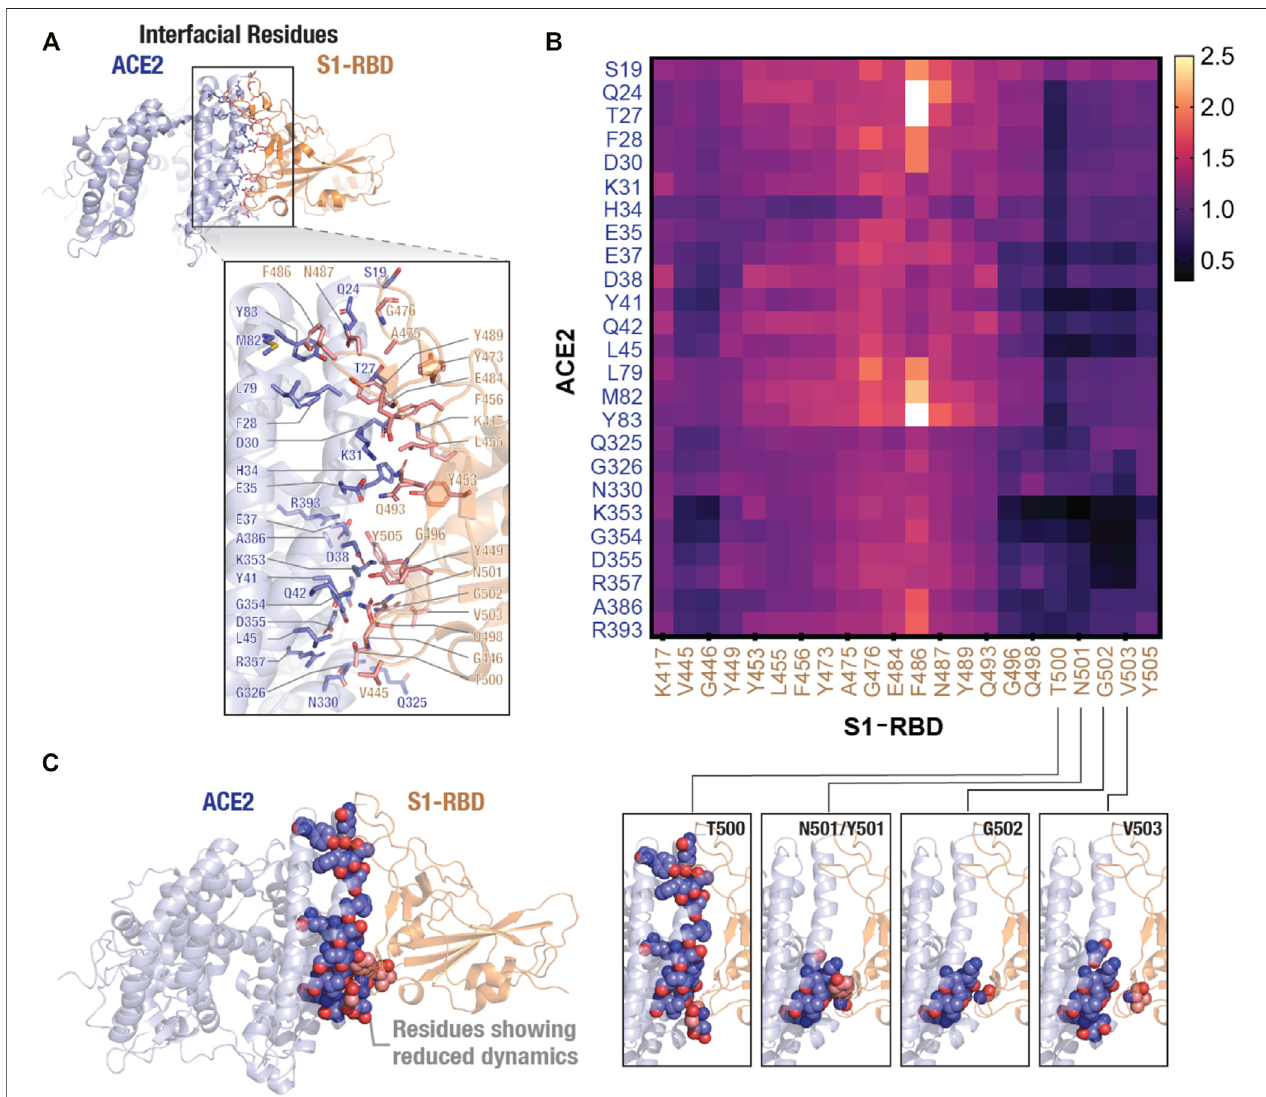
FIGURE 5 | Stabilizing effect of the N501Y mutation on ACE2-S1-RBD interfacial interaction. (A) Cartoon representation showing interfacial residues determined fromtheavailableACE2-S1-RBDcomplex(PDBID:6m0j)atacut-offdistanceof5Å.Atotalof25residues(blue)and22residues(orange)wereidenti fi edattheinterface in ACE2 and S1-RBD, respectively. (B) Heatmap representing ratio of inter-residue distance fl uctuations (standard deviation normalized to average distances) in the N501Y and WT ACE2-S1-RBD complexes.Note the decrease in thedynamicsofY501 and residuesneighboring themutation site, indicatingastabilizingeffect of the mutation. (C) Schematic showing reduced dynamics of interfacial residues in the N501Y mutant. ACE2 (blue) and S1-RBD (orange) complex showing interfacial residues with reduced dynamics in the N501Y mutant in comparison to the WT interface.